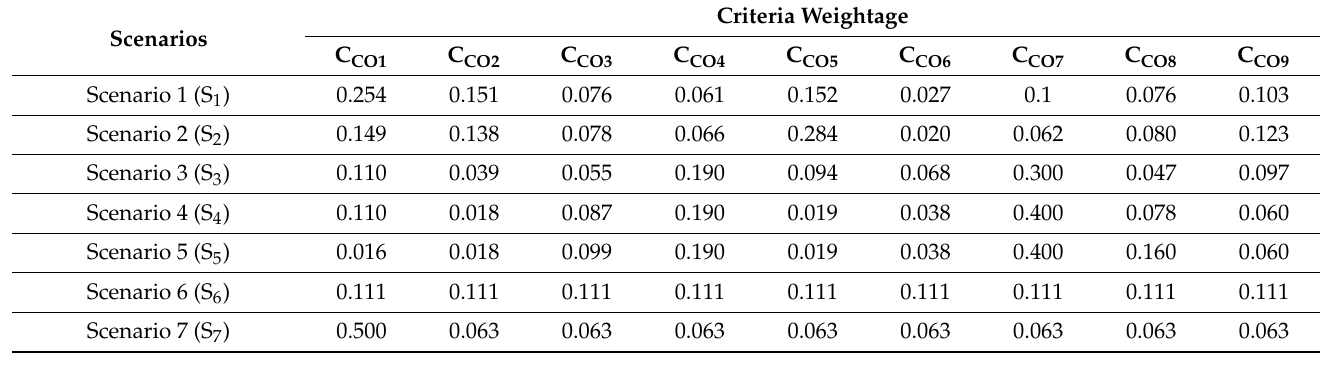
Table 7. Different scenarios of criteria weightage for sensitivity analysis.